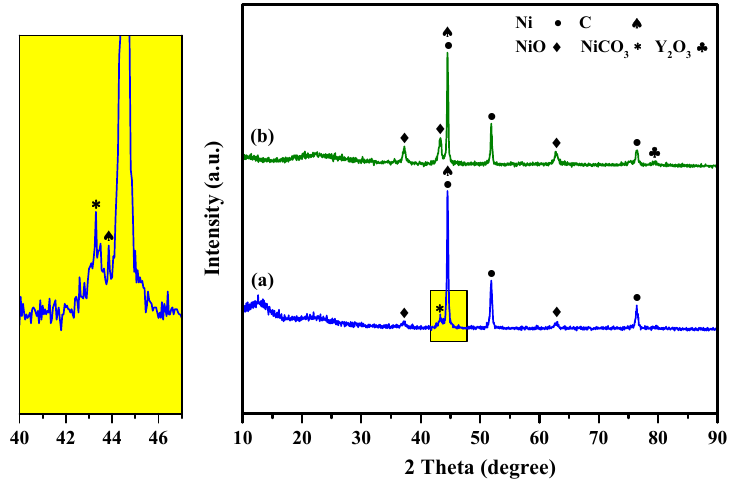
Figure 11. XRD patterns of ( a ) 25Ni/SBA-16 and ( b ) 25Ni-2.5Y/SBA-16 oxygen carriers.